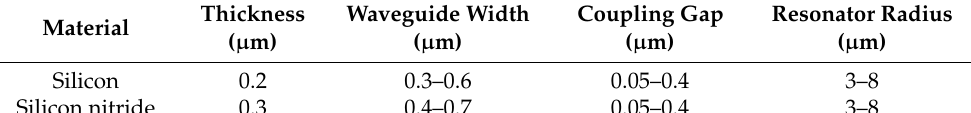
Table 1. Model parameters in the simulation.